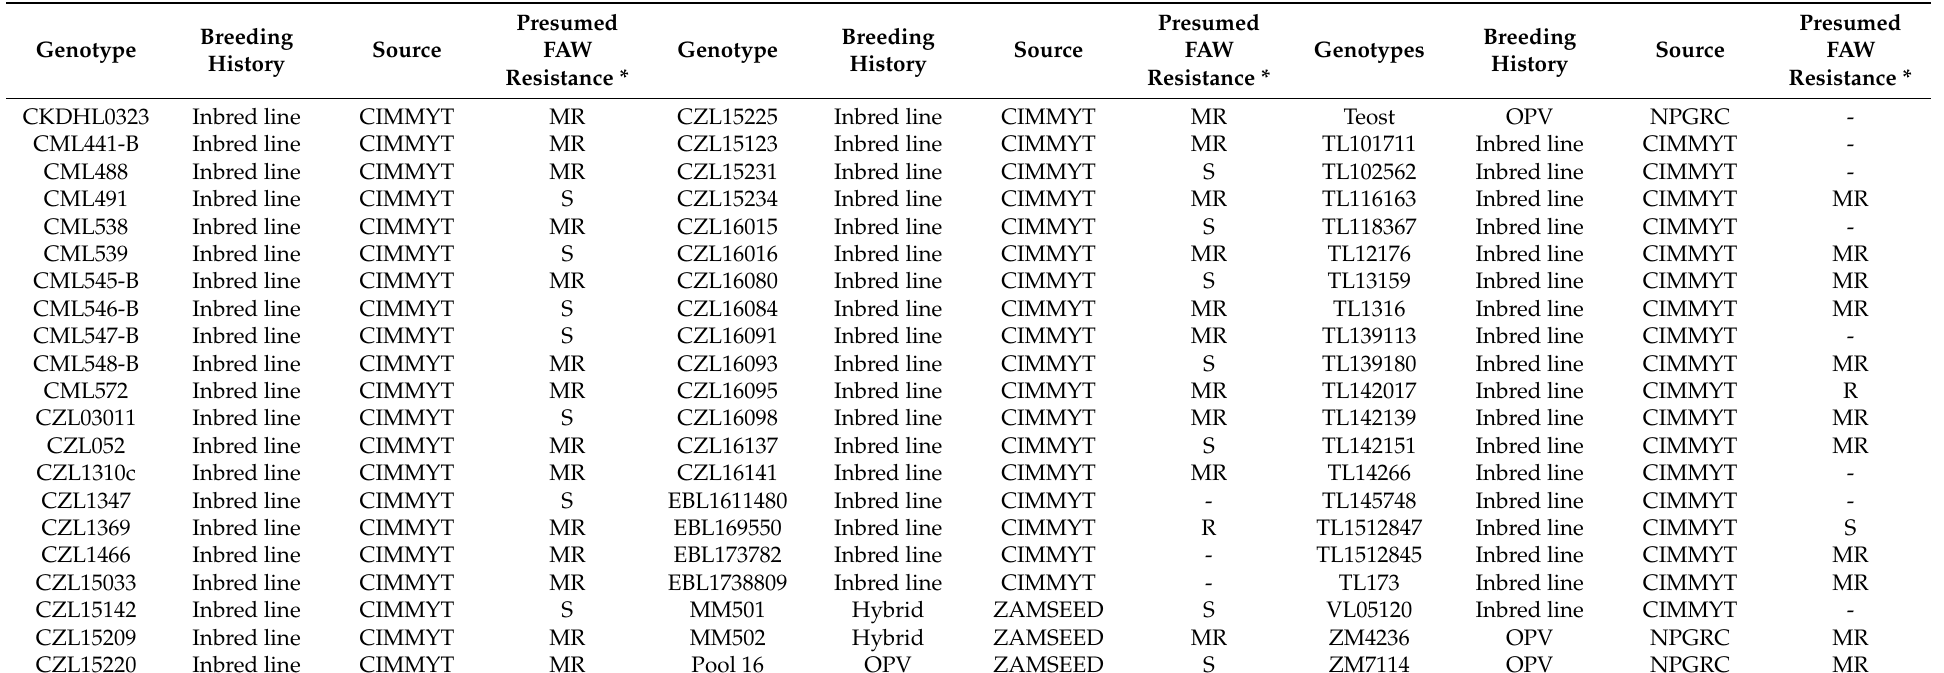
Table 2. Descriptions of maize genotypes selected for the